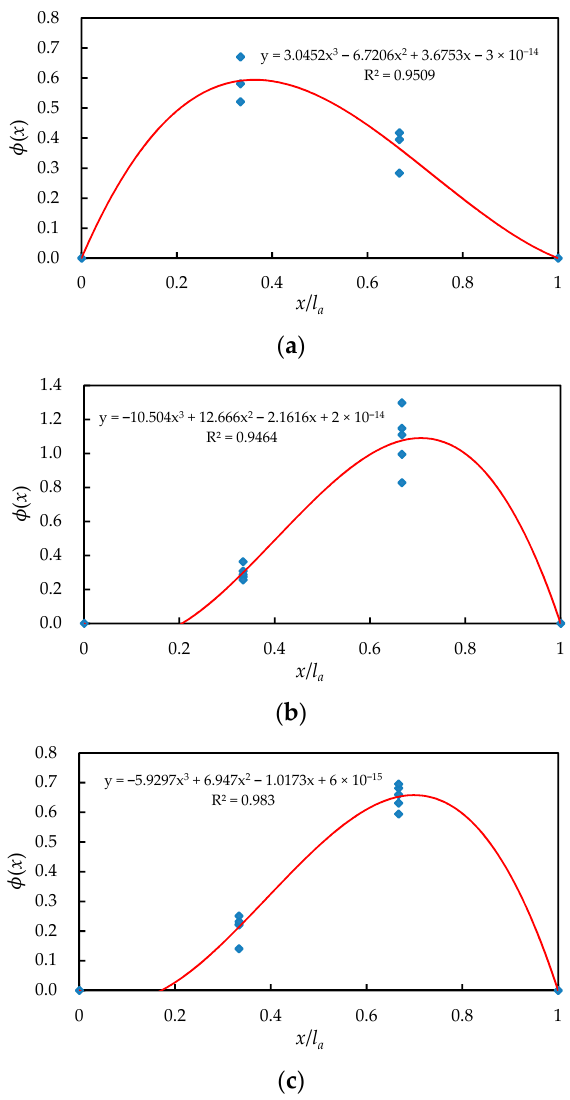
Figure 15. Position function fitting: ( a ) C20, ( b ) C40, and ( c ) C60.